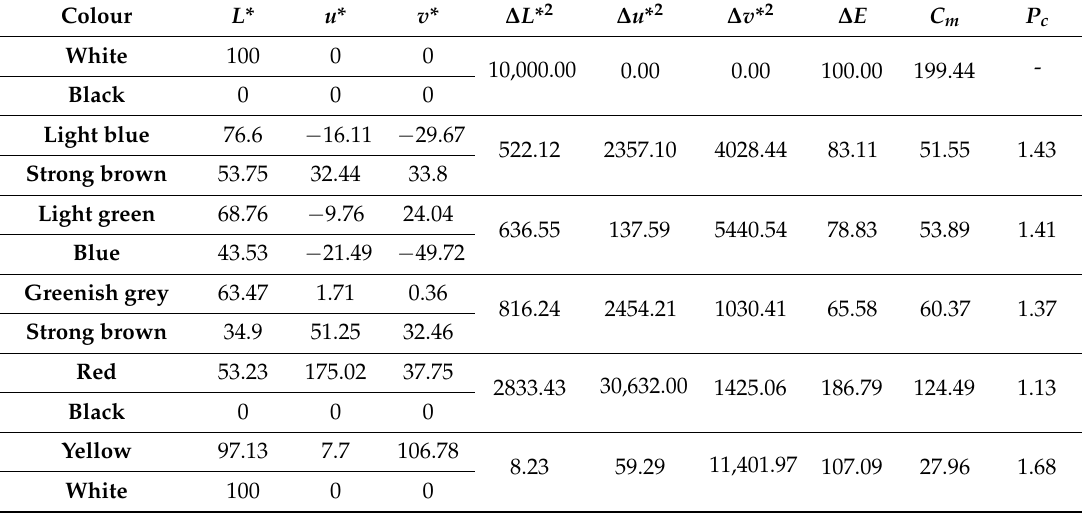
Table 2. Example values of the perception coefficient for the selected pairs of colours from L * u * v * colour